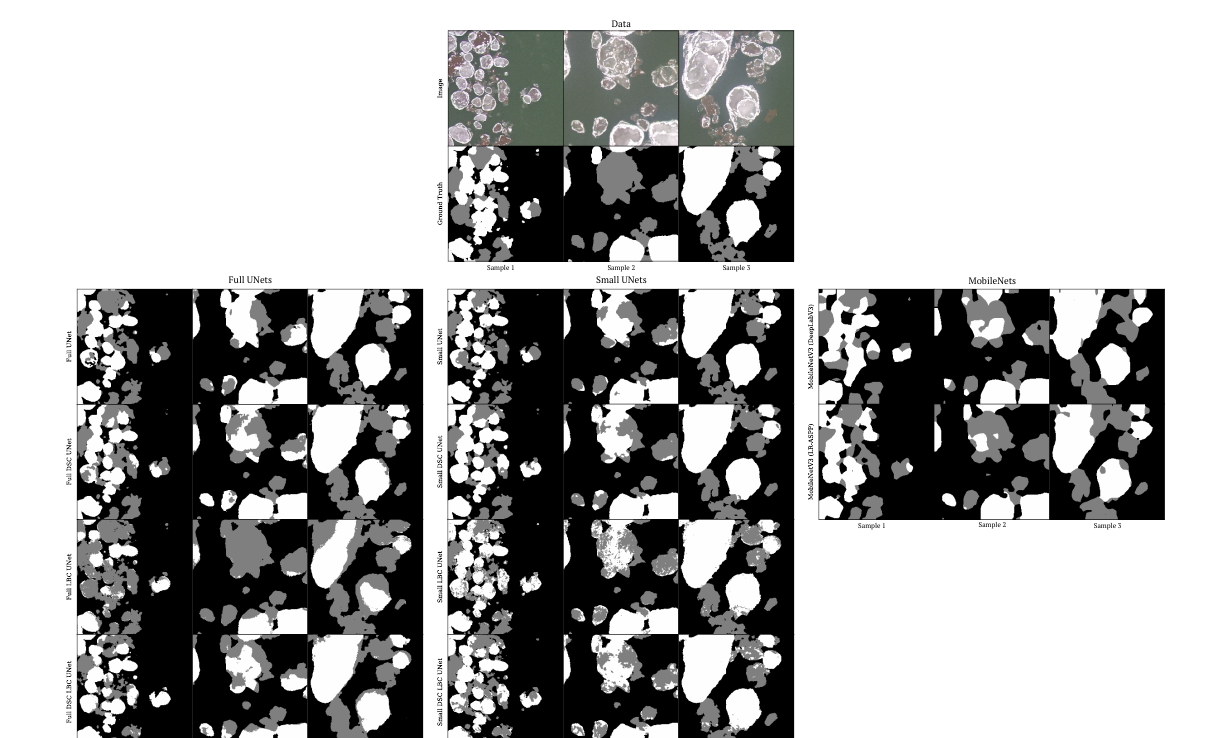
Figure 4. Segmentation results on three images from the test set. Model weights for the various models were chosen based on a stopping criterion during training (see Section 3.2). The original image and ground-truth are shown at the top, the Full UNet variations are shown on the left, the Small UNet variations are shown in the centre, and the two MobileNet variations are shown on the right. Water, anchor ice, and frazil ice are coloured in black, gray, and white, respectively. Note that details in the images and segmentation predictions can be best seen when zoomed in.